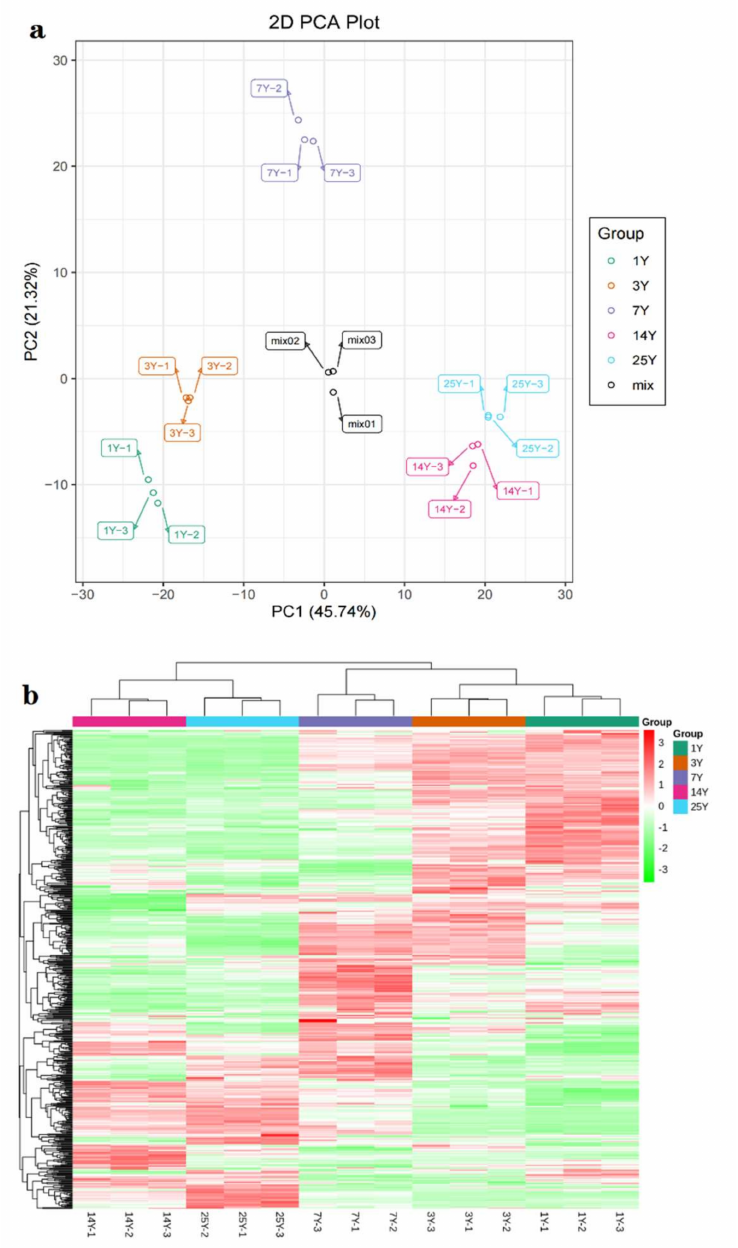
Figure 1. PCA score plot ( a ) and heat map ( b ) of the metabolites in oolong teas stored for 1 y, 3 y, 7 y, 14 y, and 25 y. Red represents high contents, while green represents low contents (ranges from − 3.0 to